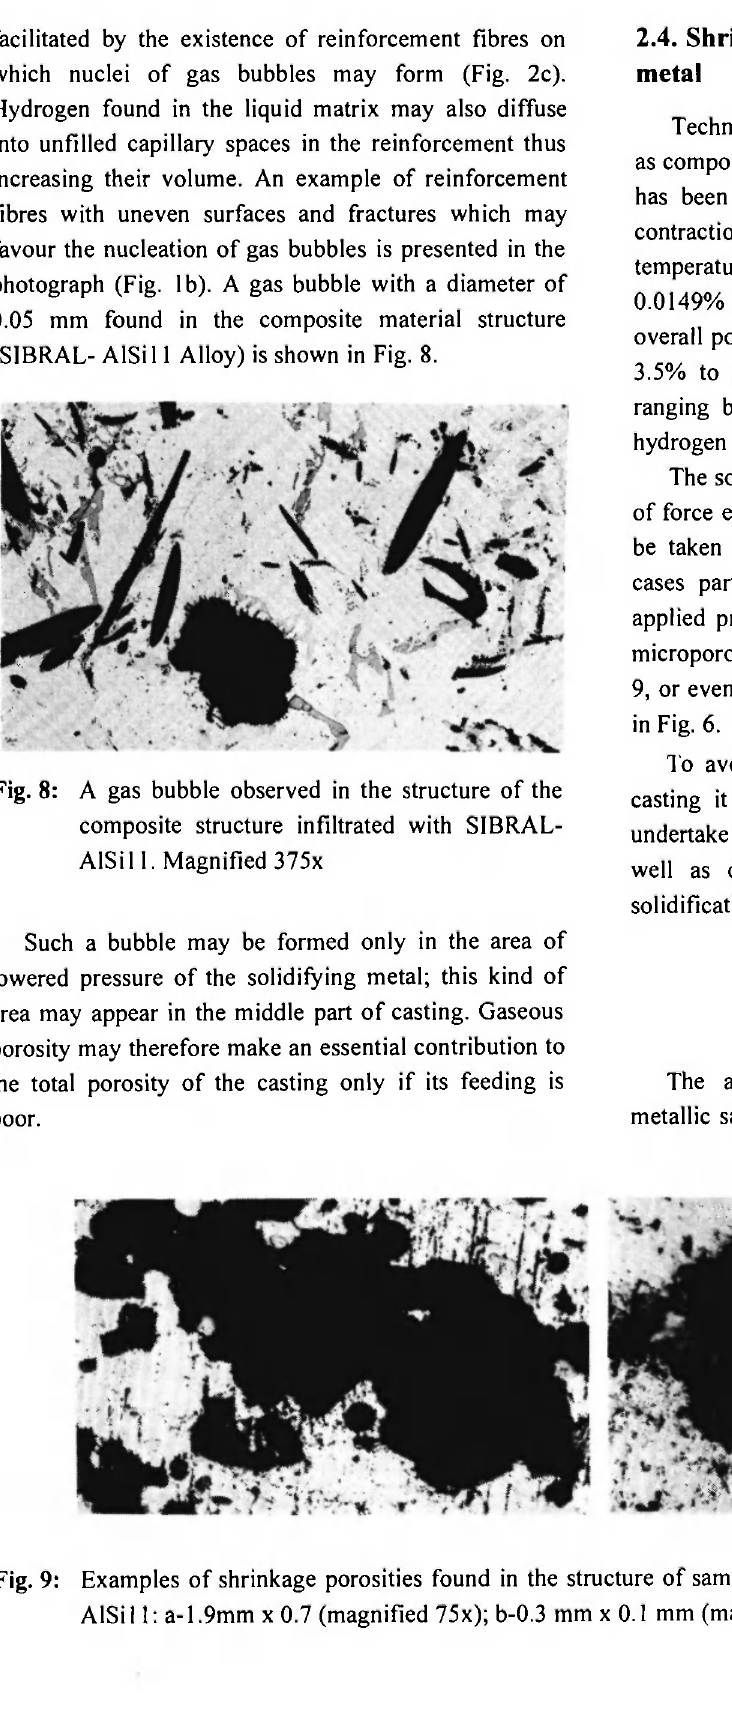
Examples of shrinkage porosities found in the structure of sample of the composite infiltrated with SIBRAL- AlSil 1: a-1.9mm χ 0.7 (magnified 75x); b-0.3 mm χ 0.1 mm (magnified